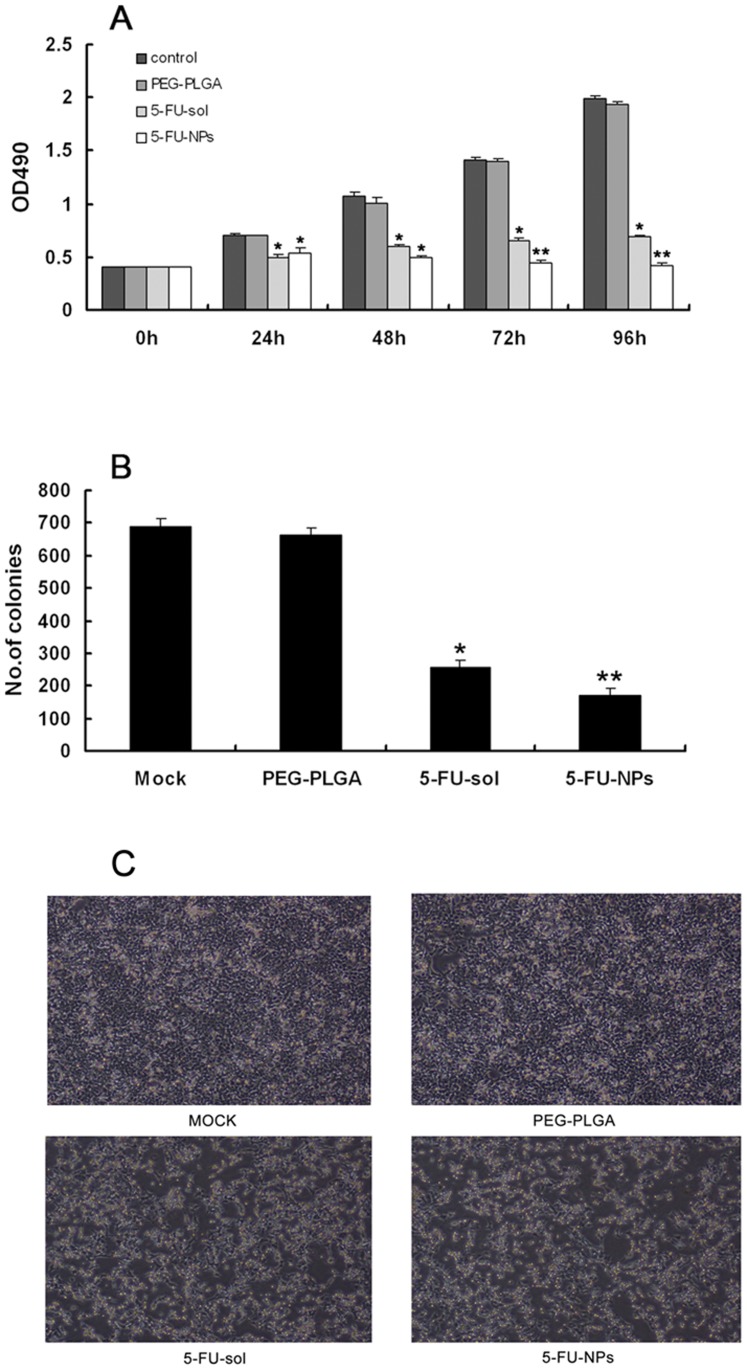
Anti-tumor nanoparticles inhibit the proliferation of colon cancer cells.(a) HCT116 cell line were added with 5-FU-NP or 5-FU-sol or PEG-PLGA or mock and subjected to a cell-viability assay in 24 h, 48 h, 72 h and 96 h. (b) A clone formation assay was performed in mock, PEG-PLGA, 5-FU-sol and 5-FU-NPs groups. * P<0.05,versus control. ** P<0.05, versus 5-FU-sol. (c) Representative photos after adding with PEG-PLGA, 5-FU-sol and 5-FU-NPs and mock.